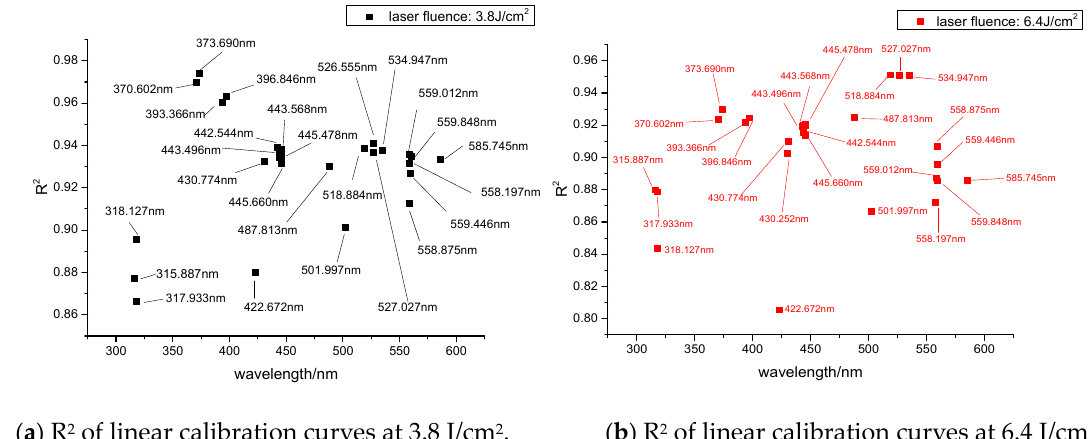
Figure 8. R 2 values greater than 0.9 at various Ca spectral lines as a function of laser energy intensity. The two laser fluences are drawn in black (3.8 J/cm 2 ) and red (6.4 J/cm 2 ).